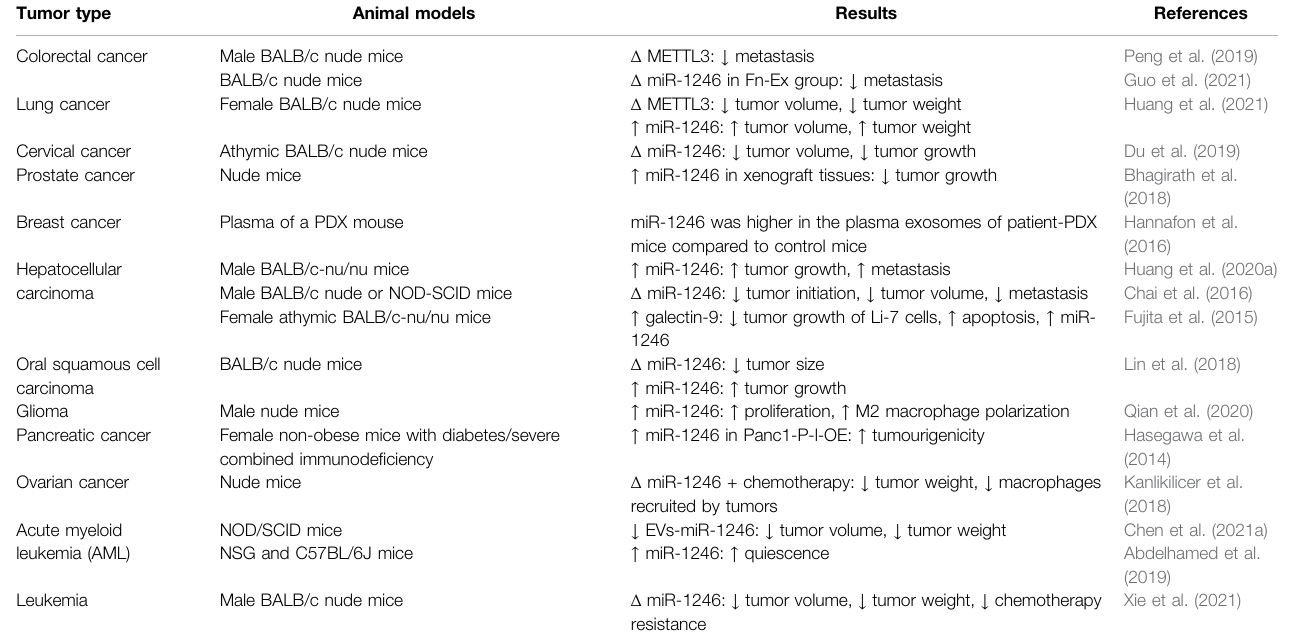
TABLE 2 | Outline of studies about the function of miR-1246 in animal models ( Δ : knock-down or deletion, PDX: derived orthotopic xenograft, NOD-SCID: non-obese diabetic/severe combined immunode fi ciency, NSG: NOD Cg-Prkdcscid Il2rgtm1Wjl/SzJ). Tumor